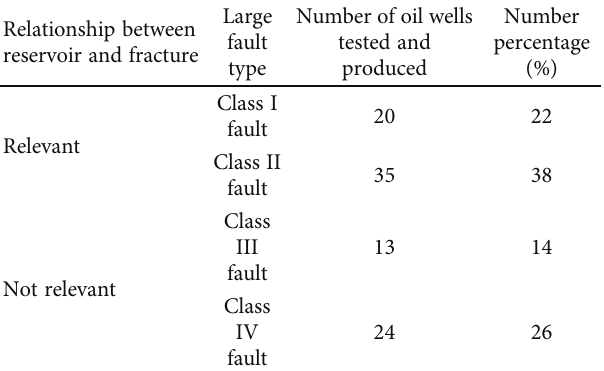
Figure 7: Well named “ 9L132-3 — 9G34 ” reservoir pro fi Table 11: Relationship between reservoir and fracture.